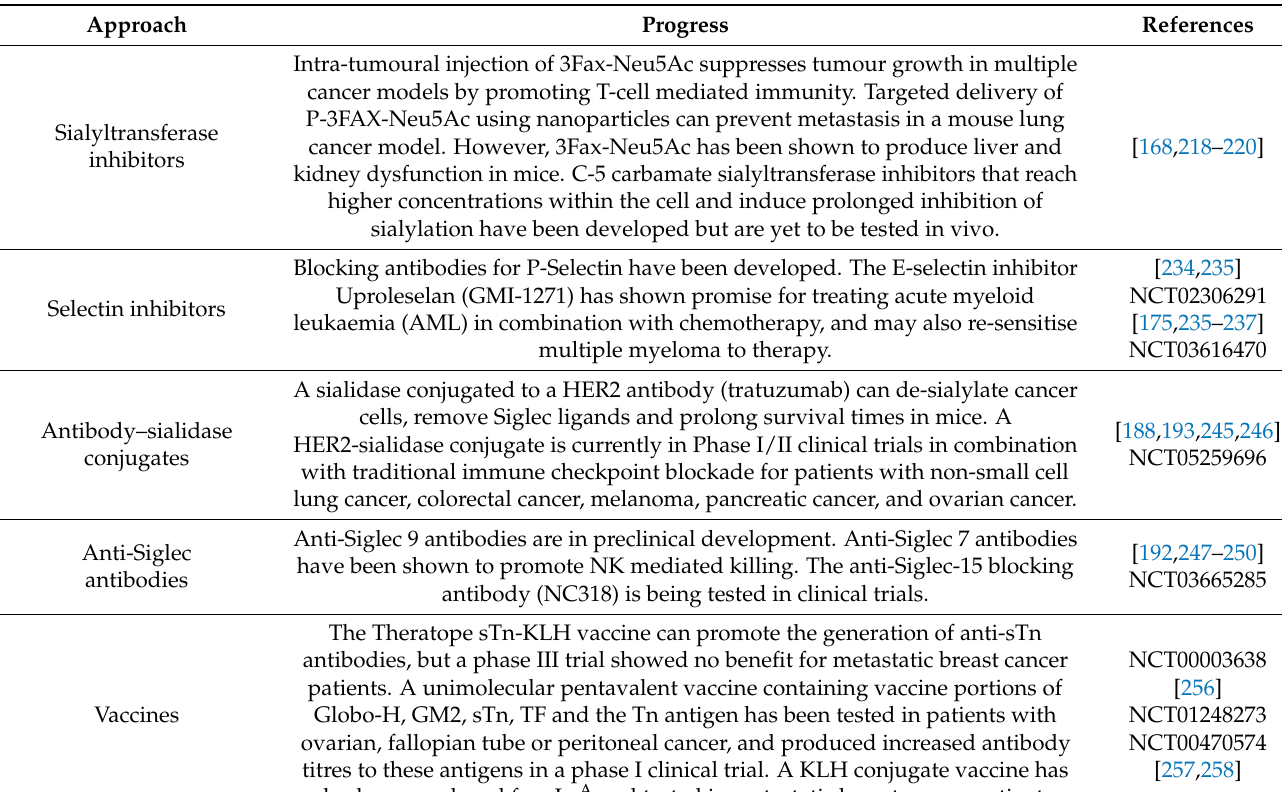
Table 2. Overview of therapeutic strategies to target aberrant sialylation in